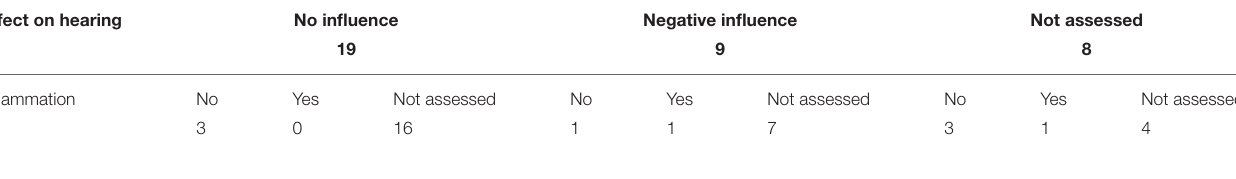
TABLE 5 | Evaluation of hearing function and